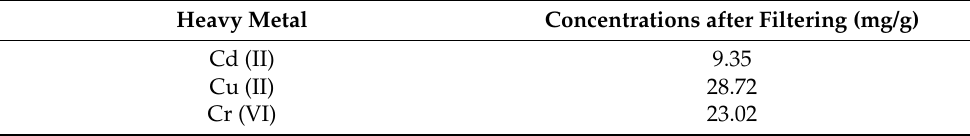
Table 7. Final concentrations of the heavy metal in rice